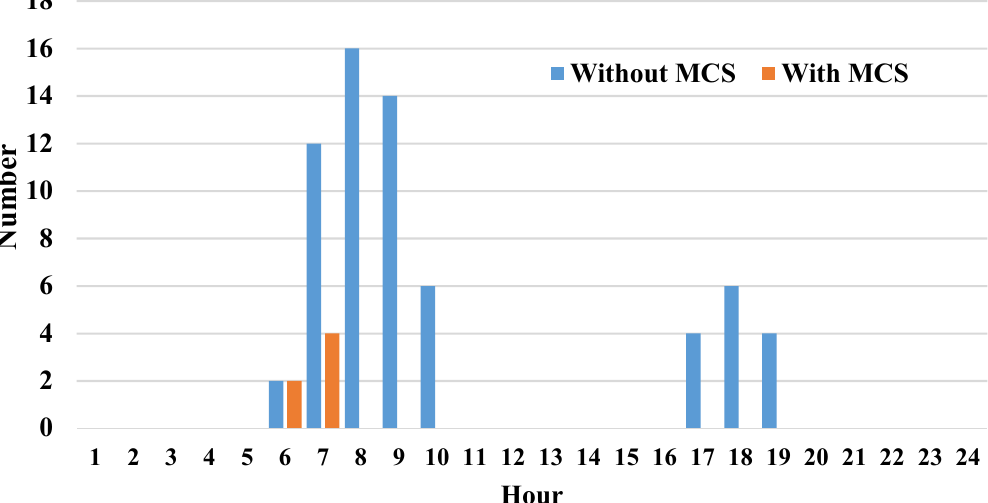
Figure 10. Hourly EVs’ charging queue at the fixed station.